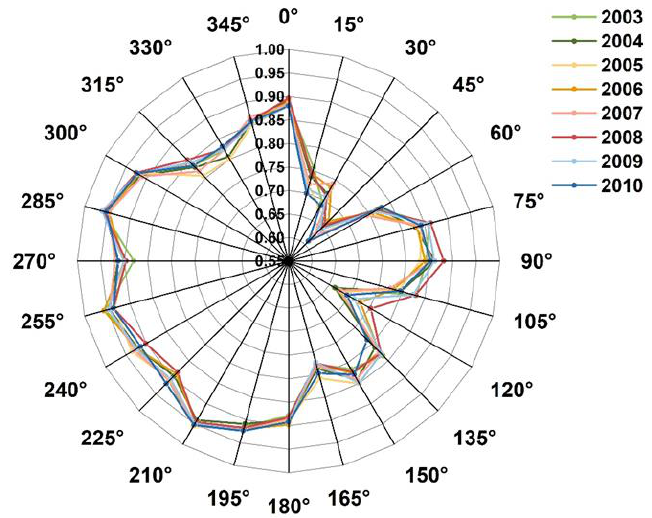
Figure 6. Distributions of yearly FTVT, along with wind directions from 2003 to 2010. Influenced by the monsoon climate, the source areas of the EC measurements were mainly concentrated in the southeast part in summer, and there was more coniferous plantation. In the non-growing season, however, the main wind direction was north and northwest. The source areas were mixed with more double-cropped rice. Therefore, the FTVT exhibited a single-peak seasonal variation from 2003 to 2010, which was higher in the growing season (May to September) than that in the non-growing season (Figure 7). The mean value of the FTVT ranged from 0.8254 to 0.8391, with a seasonal variation ranging from 0.0783 to 0.1416. Meanwhile, the FTVT from July 2006 was lower than the other years (Table 1). Compared with the other years, the source area of that month in 2006 was biased to the northeast, where more double-cropped rice was mixed